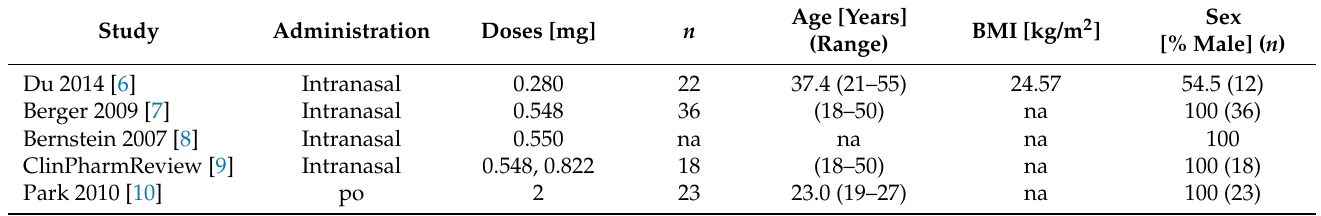
Table A1. Summary of the studies used for model development of the PK models. Age and BMI are summarized as medians and range if available. Patients’ sex is summarized as the percentage and number of male